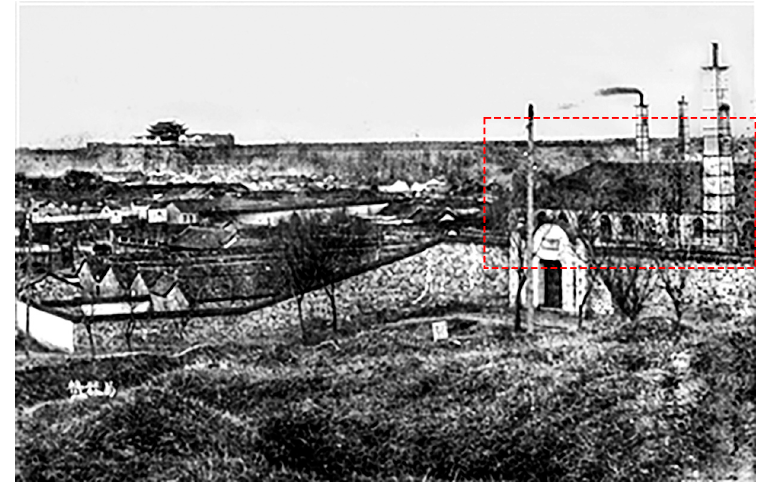
Figure 5. The Jinling Machinery Bureau and the LMF in 1889. Modified from [38].